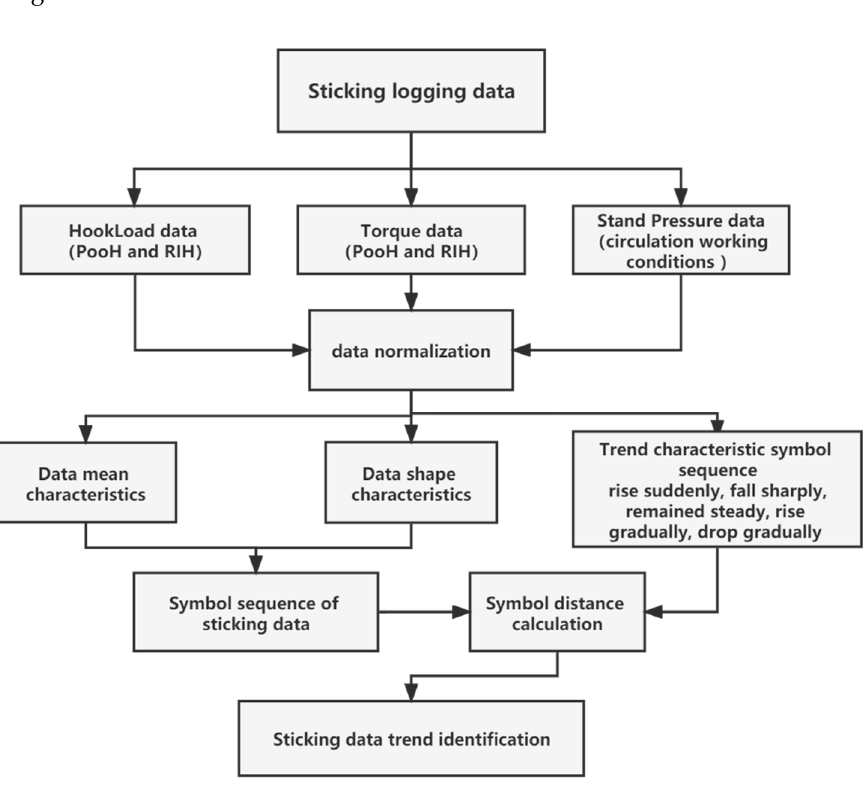
Figure 6. Flow of stuck data trend recognition based on SAX method.